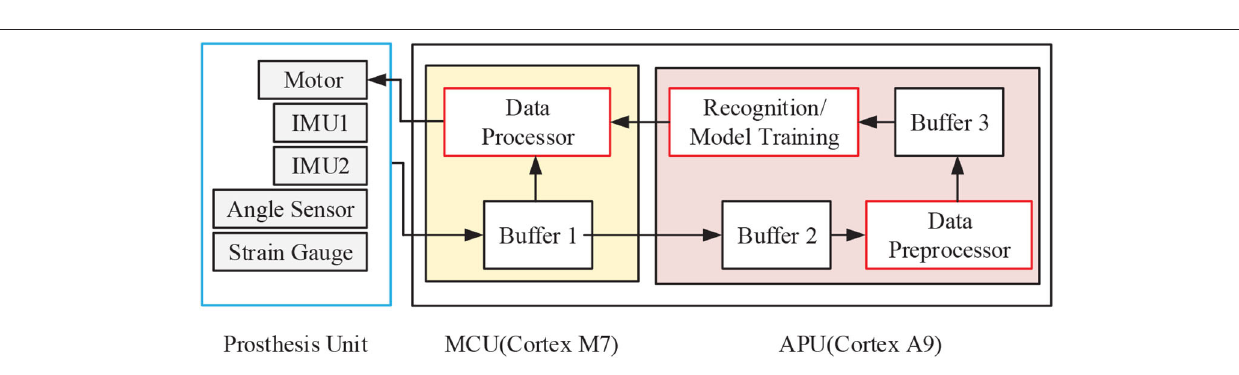
FIGURE 2 | The control circuit of robotic transtibial